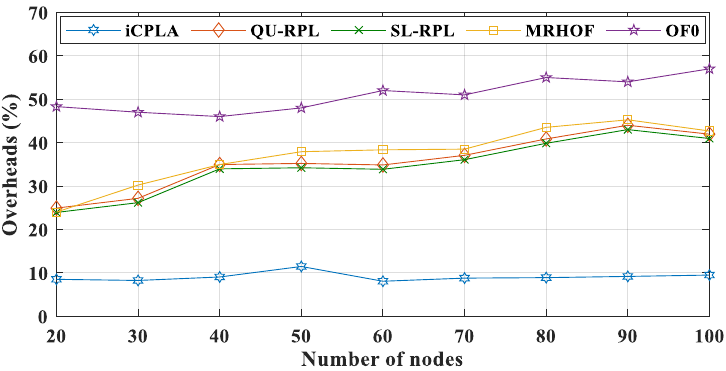
Figure 11. Comparison of total control overhead (%) between i CPLA, QU-RPL, SL-RPL, MRHOF, and OF0 with 𝛼 = 0.3 and 𝛽 = 0.7 in a network of 20 to 100 nodes.